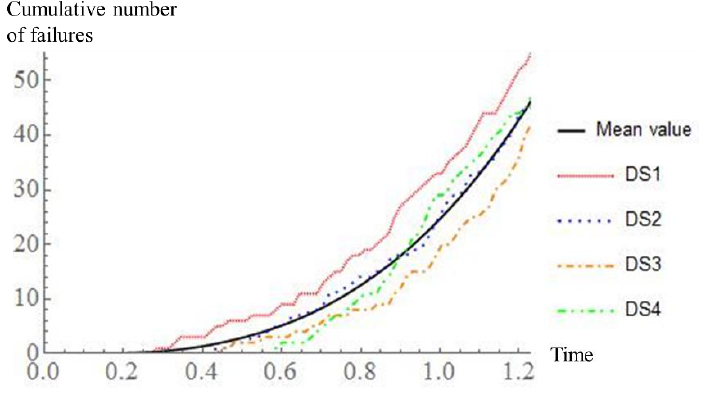
Fig. 2. Simulation data